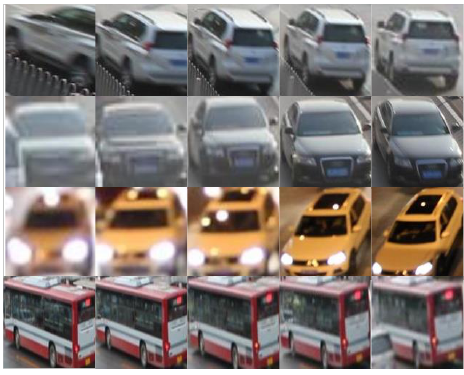
Figure 4. Images from the REID-UADETRAC dataset.